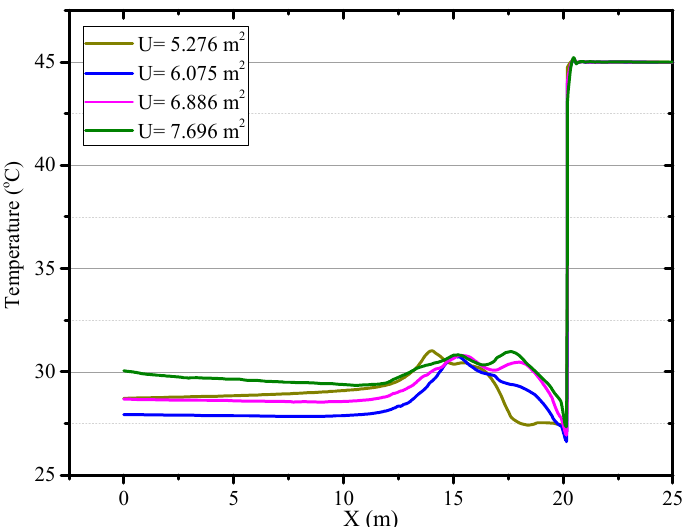
Figure 17. Air temperature distribution in Z = 0.5 m plane under different roadway section size.